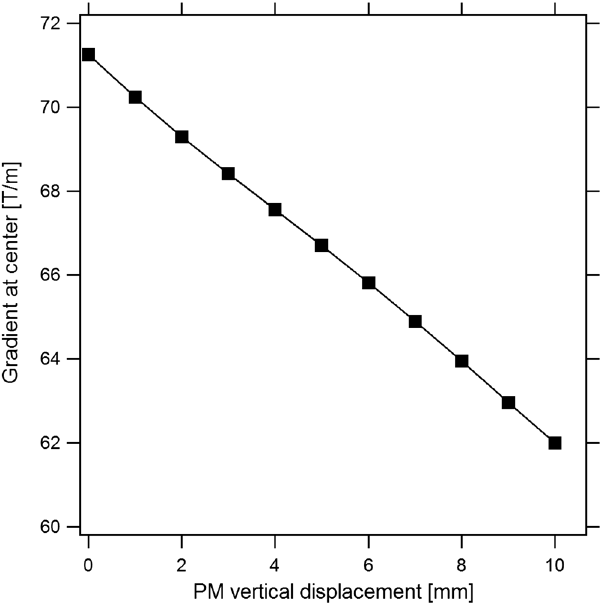
FIG. 4. Gradient reduction with PM vertical displacement.